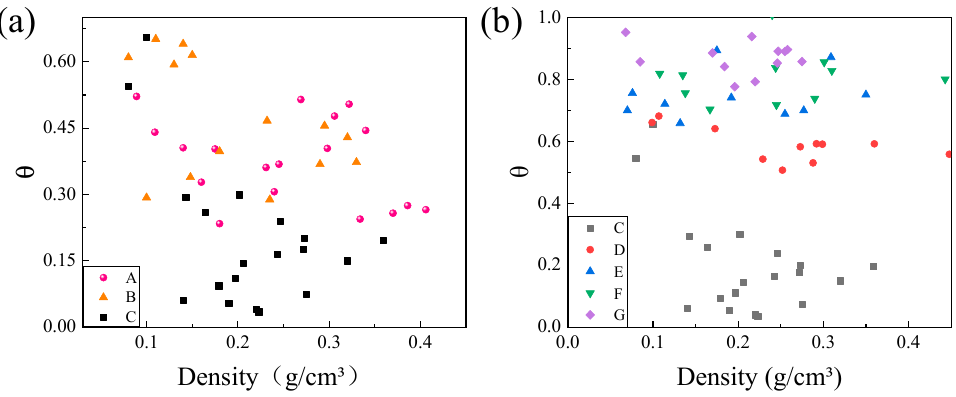
Figure 10. The relationship between compression stability and density of different structural parameters: ( a ) different length; ( b ) diameters.